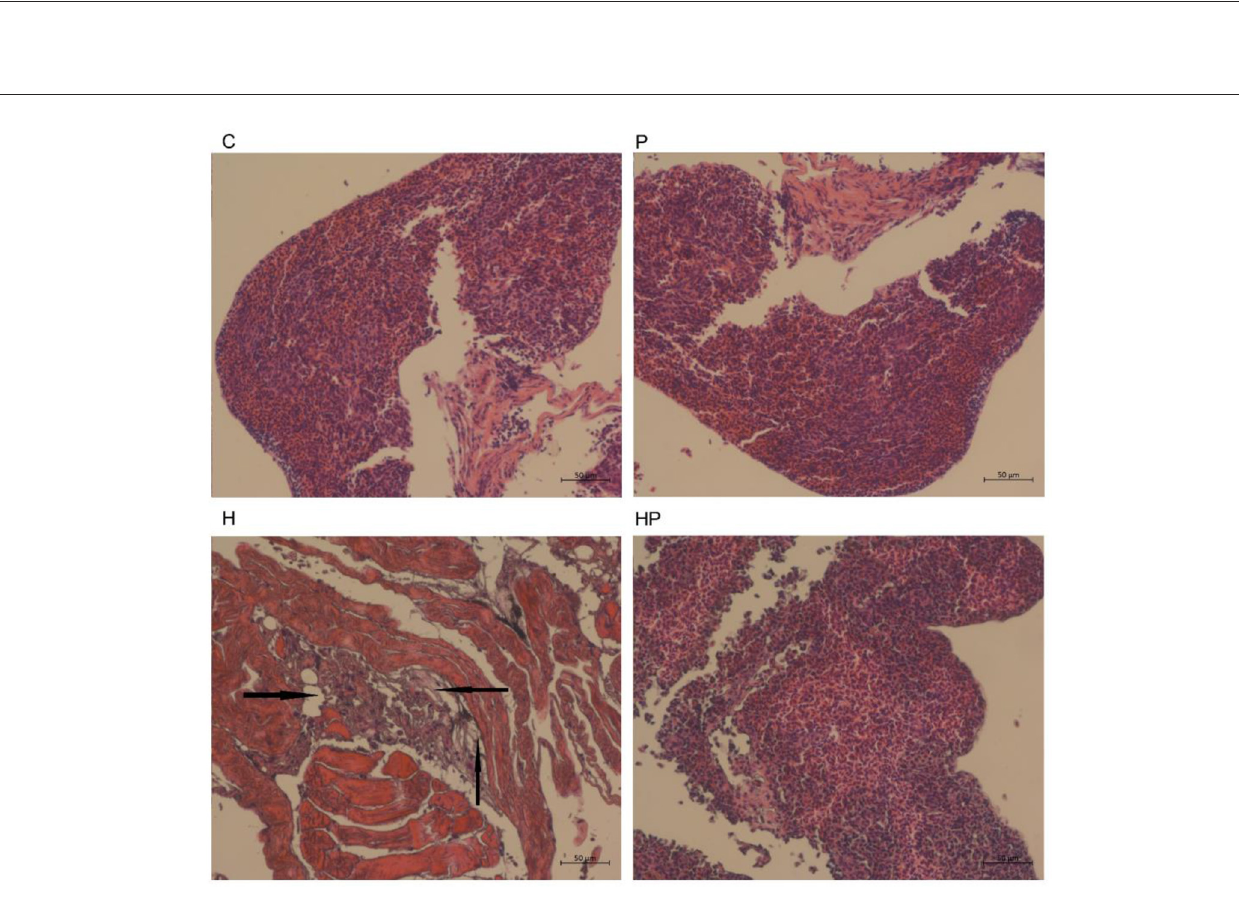
FIGURE9 Histological changes of liver sections measured by H&E staining (scale bar is 50 µ m). The black arrows indicate extensive hydropic degeneration of hepatocytes characterized by swollen, pale, vacuolated